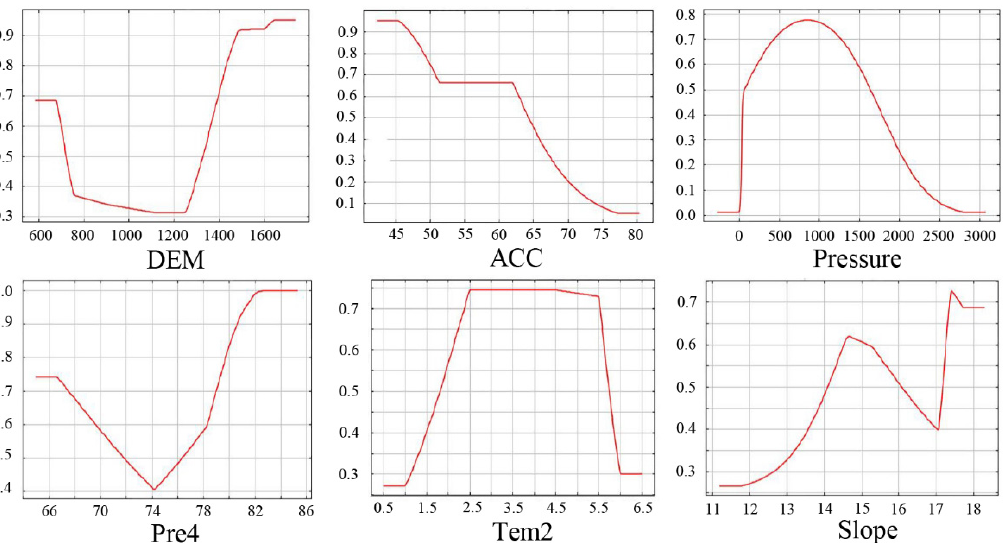
Figure A3. Feedback curves of dominant geographic environment variables for Chinese fir. DEM represents digital elevation model; Acc represents accumulated temperature; Pressure represents air pressure; Pre4 represents precipitation deviation; Tem2 represents annual average diurnal temperature difference.